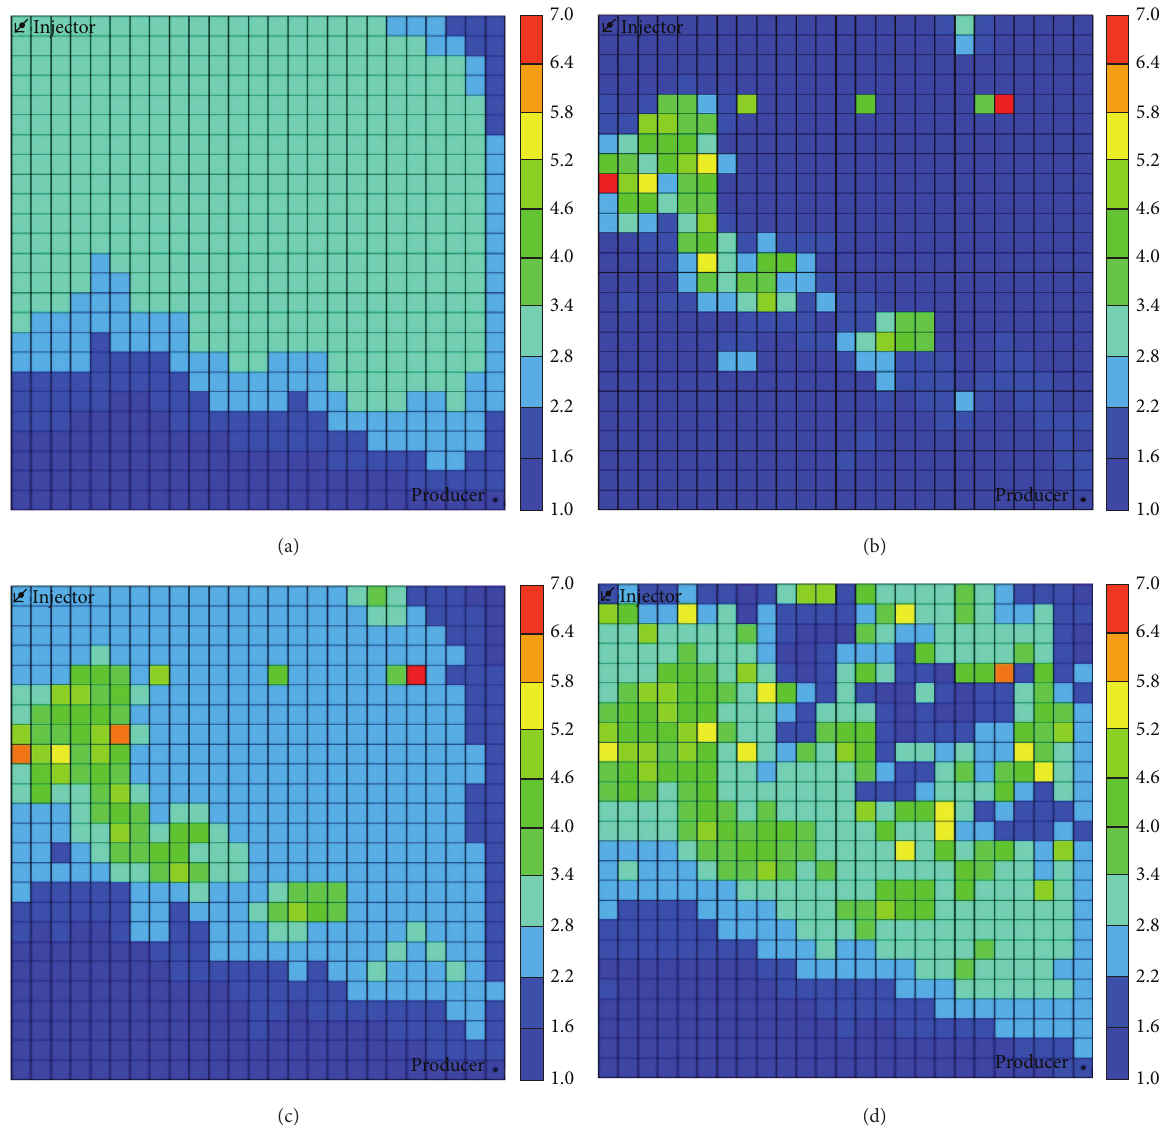
Figure 7: RRF distribution in heterogeneous reservoir by calculating assignment permeability reductions from four different matching functions: (a) constant RRF, (b) RRF = 𝑎/𝑘 2 + 1, (c) RRF = 𝑎 1 /𝑘 2 + 𝐶 M . Trap + 1, and (d) RRF = 𝑎 1 /𝑘 2 + 𝐶 M . Trap + 1 (𝑘 ≤ 0 . 45 𝑒 − 12 m 2 ) or = /𝑘 2 + 1 (𝑘 > 0 . 45 𝑒 − 12 m 2 ) 𝑎 2